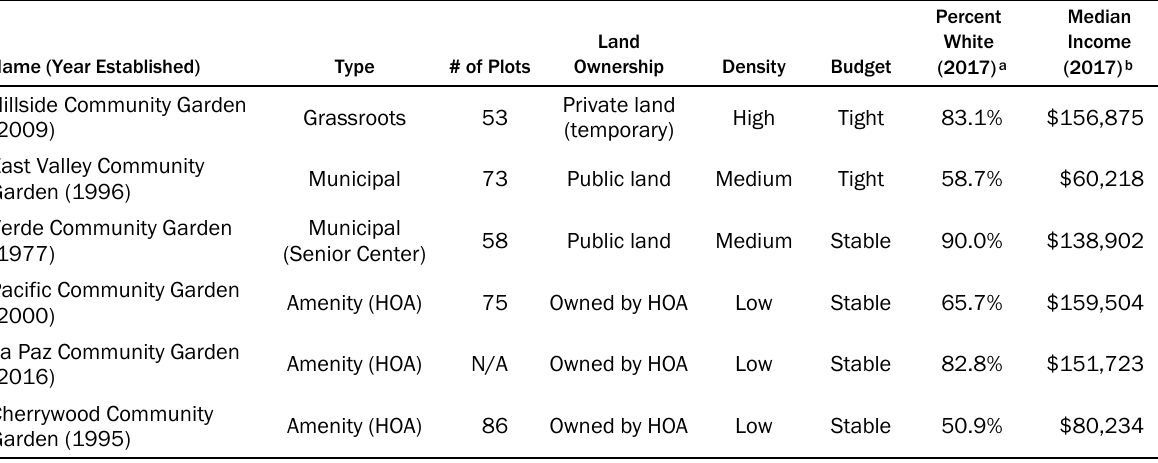
Table 1. Qualitative Research Sample Community Garden